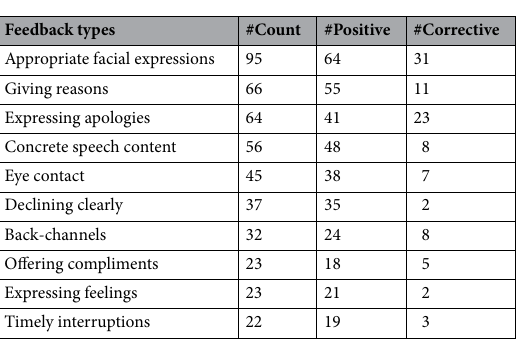
Figure 5. Frequency count of feedback by experienced trainers.